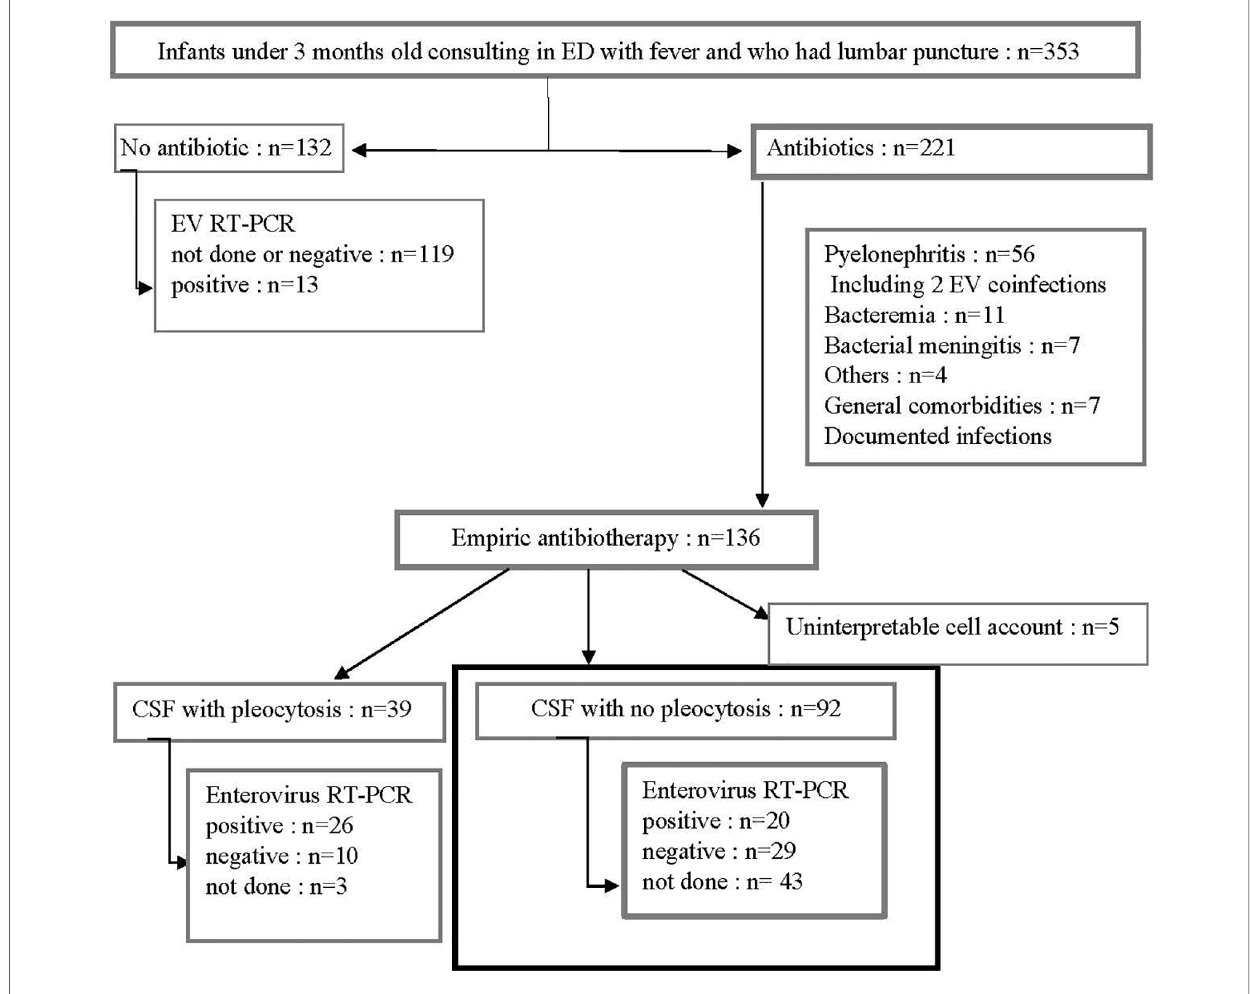
FIGURE 1 Patient fl ow chart. During four consecutive EV endemic periods, all febrile infants under 3 months old who had a lumbar puncture performed were screened. We selected those who received empiric antibiotic treatment, with no apparent cause of fever, and without pleocytosis (bold square). ED, emergency department; EV, enterovirus; RT-PCR, reverse transcriptase polymerase chain